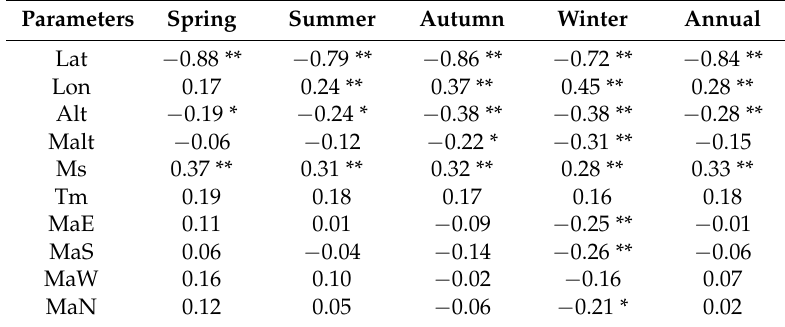
Table 2. Correlation coefficients between the total seasonal and annual precipitation and the geographical and topographical factors (all